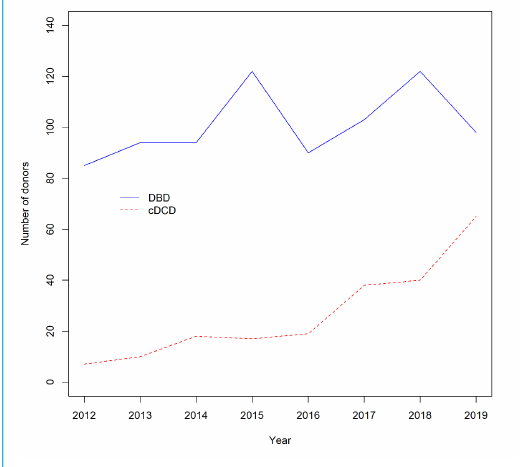
Figure 3: Number of referred cDCD (red dotted line) and referred DBD (blue line) donors from Switzerland from whom at least one organ was offered for transplantation by Swisstransplant from 2012–2019. cDCD: controlled donation after circulatory death; DBD: donation after brain